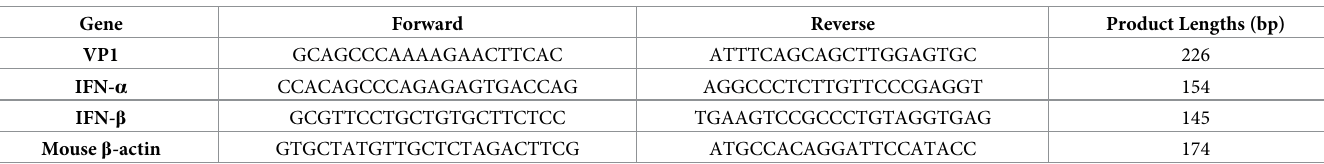
Table 1. Primers used in this